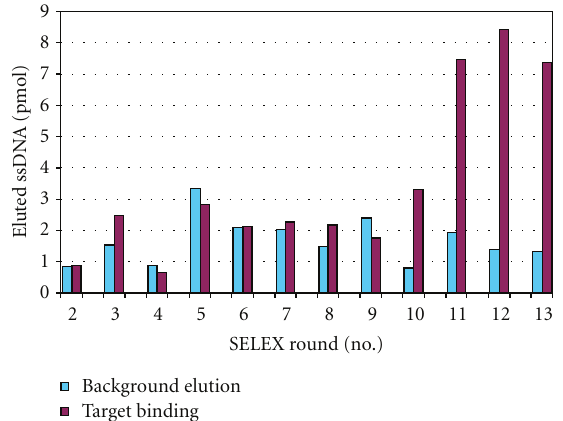
Figure 3: Enrichment of fluorescein-labeled aptamers during 13 rounds of Capture-SELEX for the target mixture consisting of kanamycin A disulfate salt dihydrate, sulfacarbamide, sulfamethox- azole, and sotalol hydrochloride, each 1 mM in selection bu ff er. Amounts of eluted single stranded DNA (ssDNA) in the target binding step (dark red) and in the background elution step (blue) are shown. As the starting oligonucleotide library initially was not fluorescein labeled, there are no bars for round